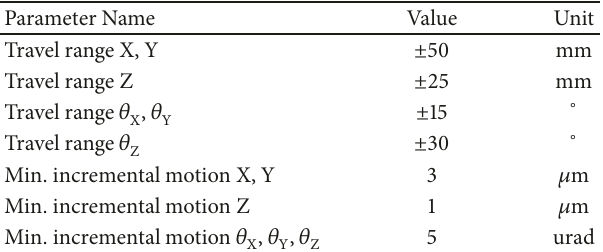
Table 2: Parameters of the 6-Axis